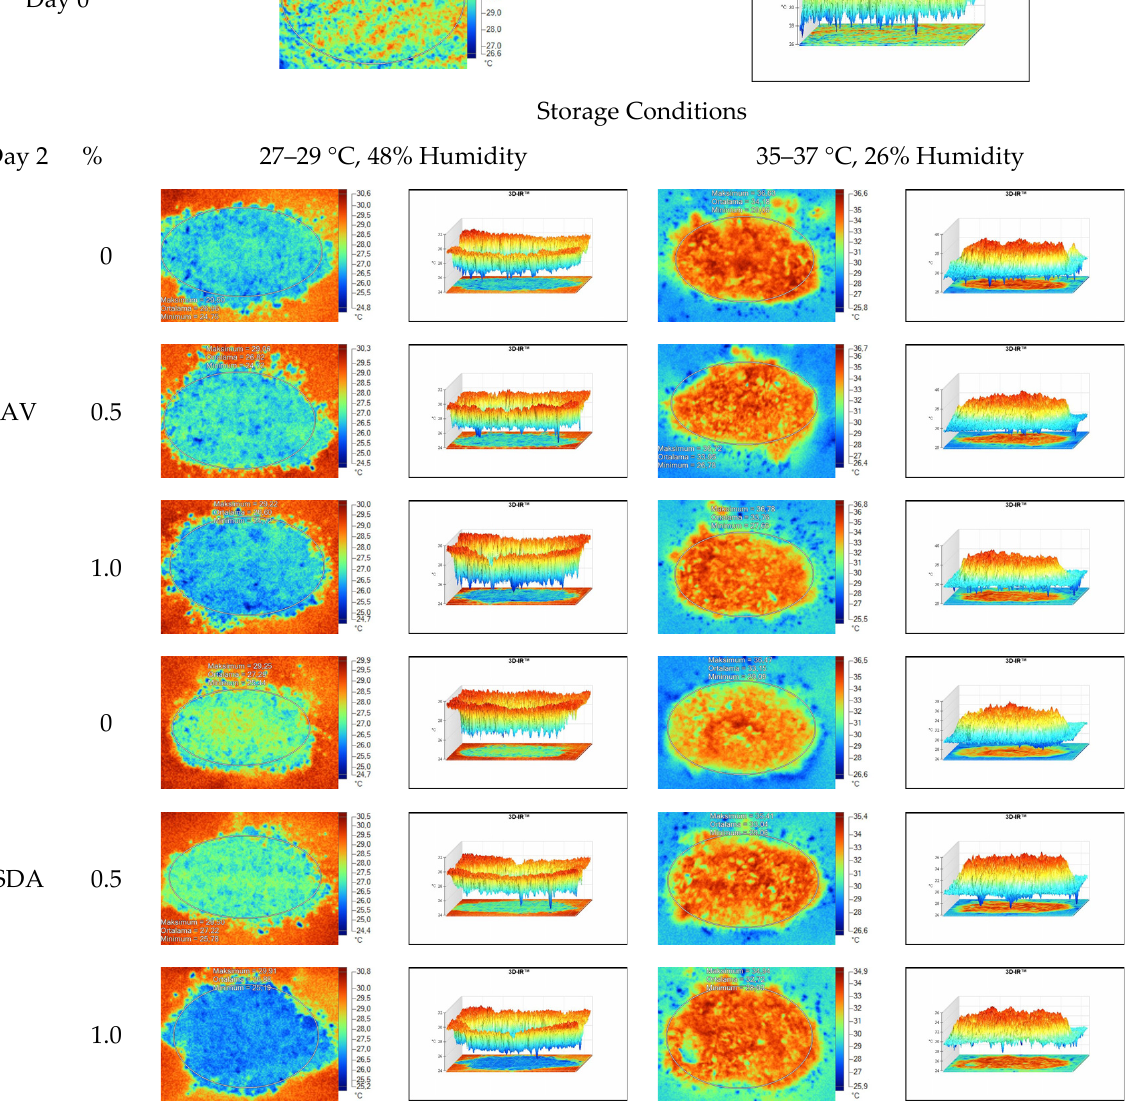
Figure 5. Thermal camera imaging samples of aerobic stability on day 2 (Ambient temperature = 22 °C; AV: Apple vinegar; SDA: Sodium diacetate).